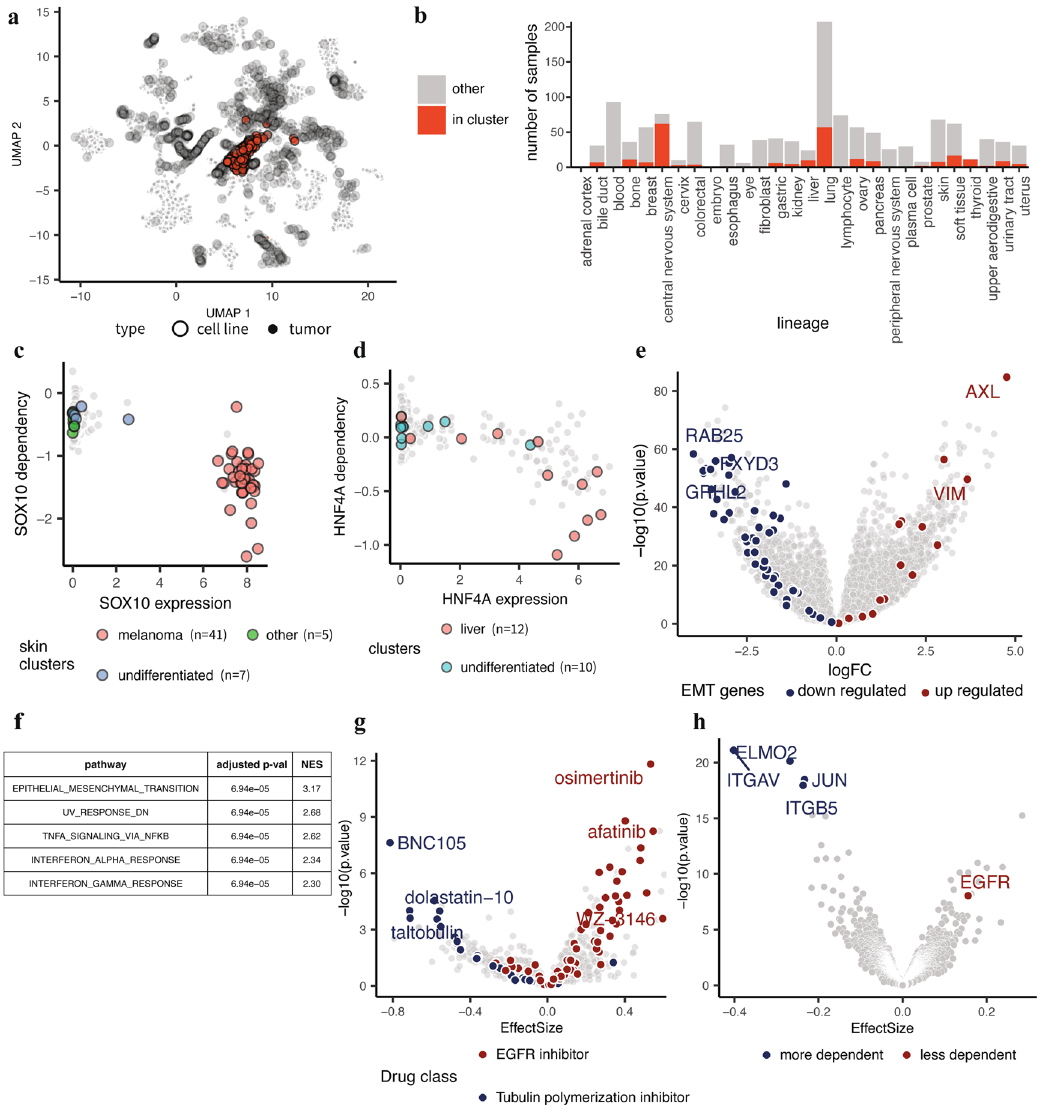
Fig. 5 A cluster of cell lines show EMT signature and integrin-related dependencies. a A cluster of 252 undifferentiated cell lines within the global Celligner-alignment. b Composition of the cell lines within the cluster ( n = 252 cell lines). c Skin cell lines within the cluster do not express and do not depend on SOX10. d Liver cell lines within the cluster have lower expression of, and weaker dependency on, HNF4A. e Differential expression analysis shows an up-regulated mesenchymal pro fi le and f enrichment of the EMT pathway for cell lines in the cluster. P -values are based on a gene-permutation test and adjusted using the Benjamini-Hochberg procedure (Methods, ‘ Gene set enrichment analysis ’ ). g Differential drug vulnerability analysis shows decreased sensitivity to EGFR inhibitors and increased sensitivity to tubulin polymerization inhibitors for cell lines in the cluster. h Differential dependency analysis shows stronger integrin-related dependencies for cell lines within the